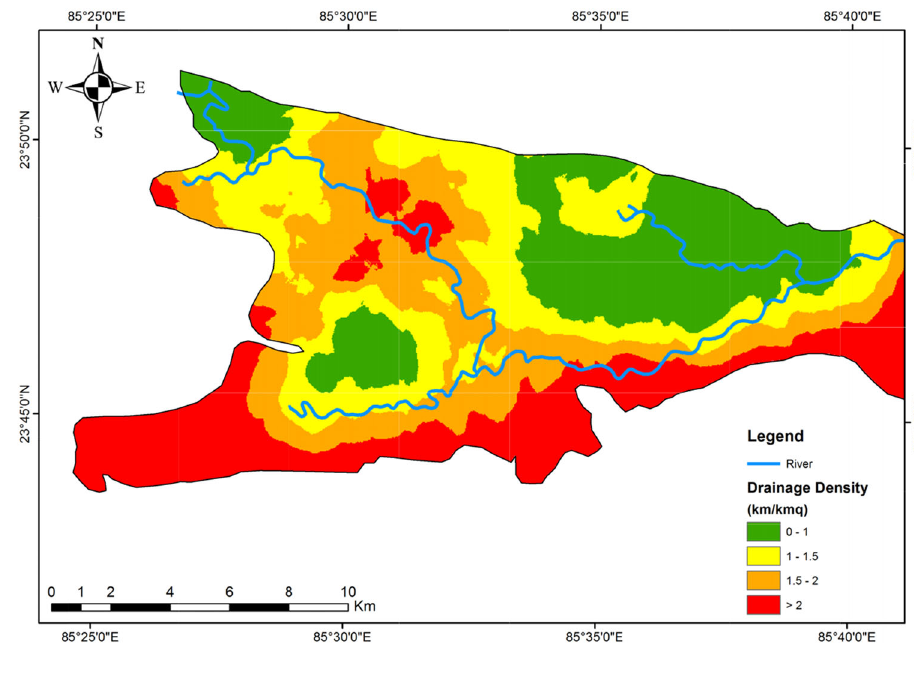
Fig. 5 Soil class map of